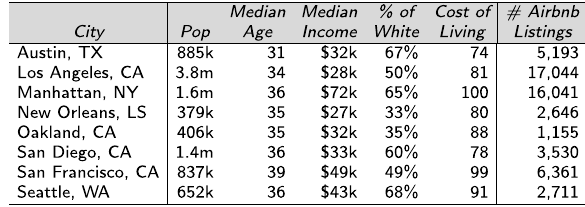
Table 1 Summary characteristics of the 8 chosen U.S.